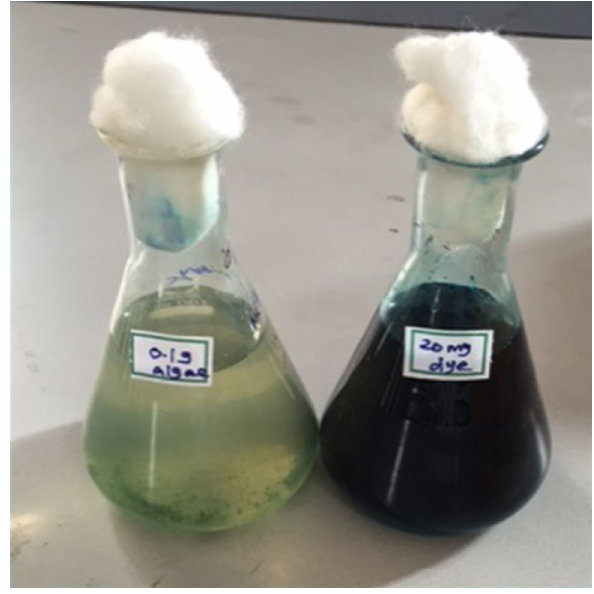
Fig. 1 Sargassum wightii -treated and untreated BG